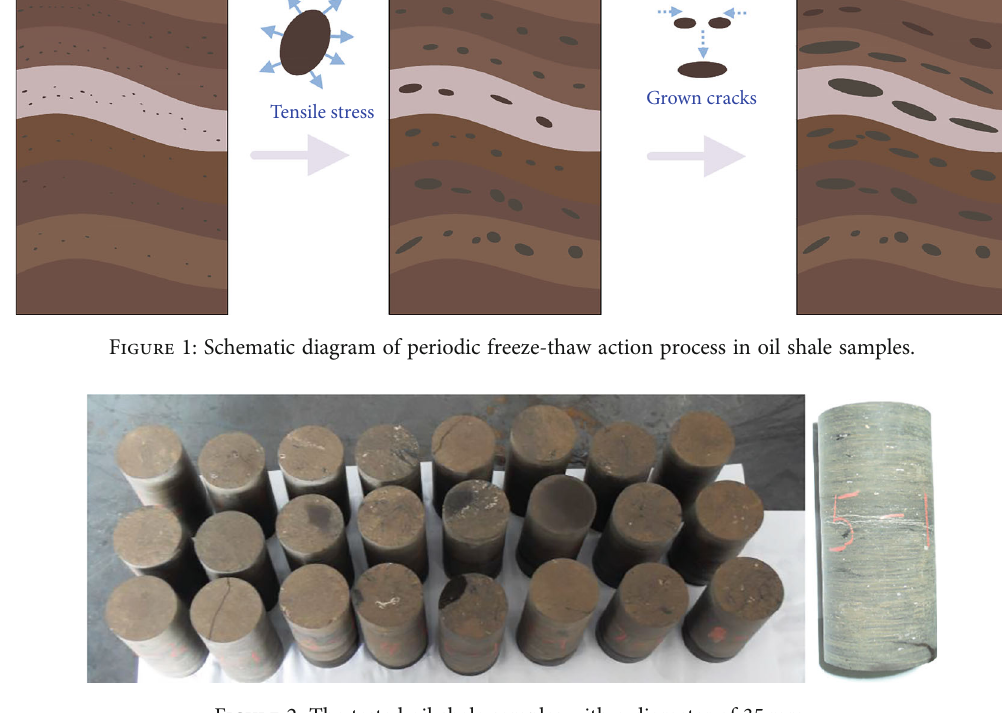
Figure 2: The tested oil shale samples with a diameter of 35mm. Table 1: Physical parameters of the tested oil shale samples. Dry density ρ (g/cm 3